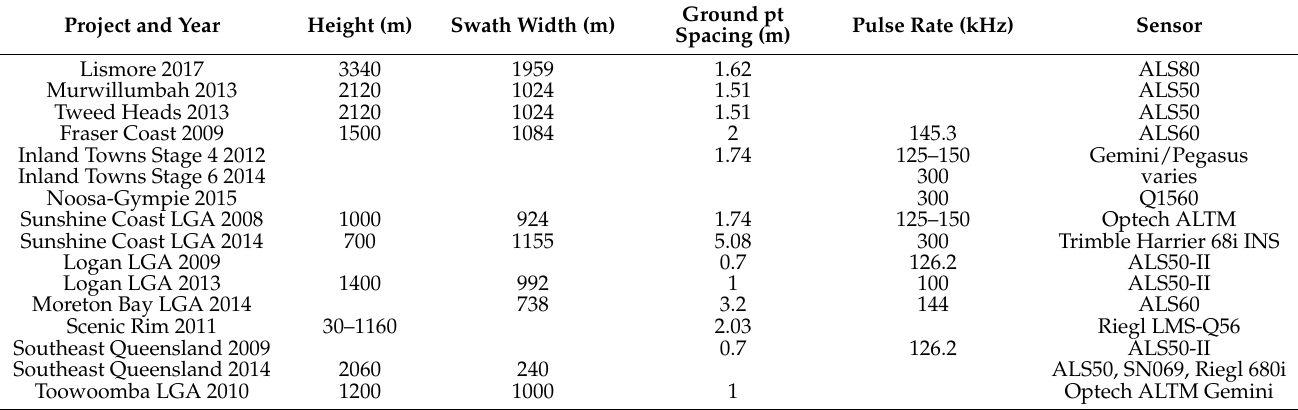
Table 2. Available metadata for ALS data used in this paper. Point density was not included, but most datasets include ground point spacing. Following Reference [43], we regard all datasets to be suitable for our study. All data was downloaded from ELVIS (Elevation Information System) at https://elevation.fsdf.org.au/, accessed on 24 June